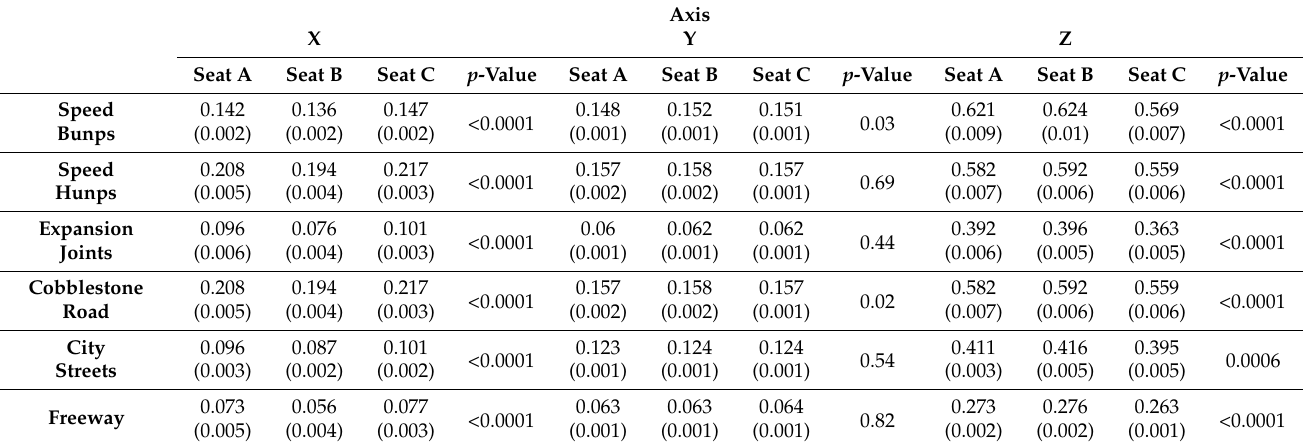
the data analysis. The A(8) values showed that WBV exposures were predominant in the vertical direction (Z-axis). The A(8) values on the speedbumps, speedhumps, and cobble- stone segments were higher than the EU daily vibration action limit (0.5 m/s 2 ) [34,36] as shown in Table 4. There were very small differences among the seats in the X-axis vibra- tion exposures with Seat C having slightly higher exposures. There were no differences in the Y-axis WBV exposures among the seats. The Z-axis WBV exposures showed small differences among the seats with Seat C having the lowest exposure. In general, the seat- measured A(8) values tended to be higher than the floor-measured values except for the speedbump segment. When comparing the three seats, Seat C had the lowest A(8) values for all six road segments ( p < 0.0001). Moreover, Seat C had superior vibration attenuation performance in the speedbumps, speedhumps, and expansion-joint segments where the vibration was more impulsive than the city street or freeway segments. Lastly, Seat C was the only seat that reduced the vibration magnitudes over the expansion joint segment. Table 4. Mean (standard error) laboratory vibration exposures (weighted average vibaration: A(8) m/s 2 ) across the three seats by road type comparing the three seats ( n = 10). Axis X Y Z Seat A Seat B Seat C p -Value Seat A Seat B Seat C p -Value Seat A Seat B Seat C p -Value